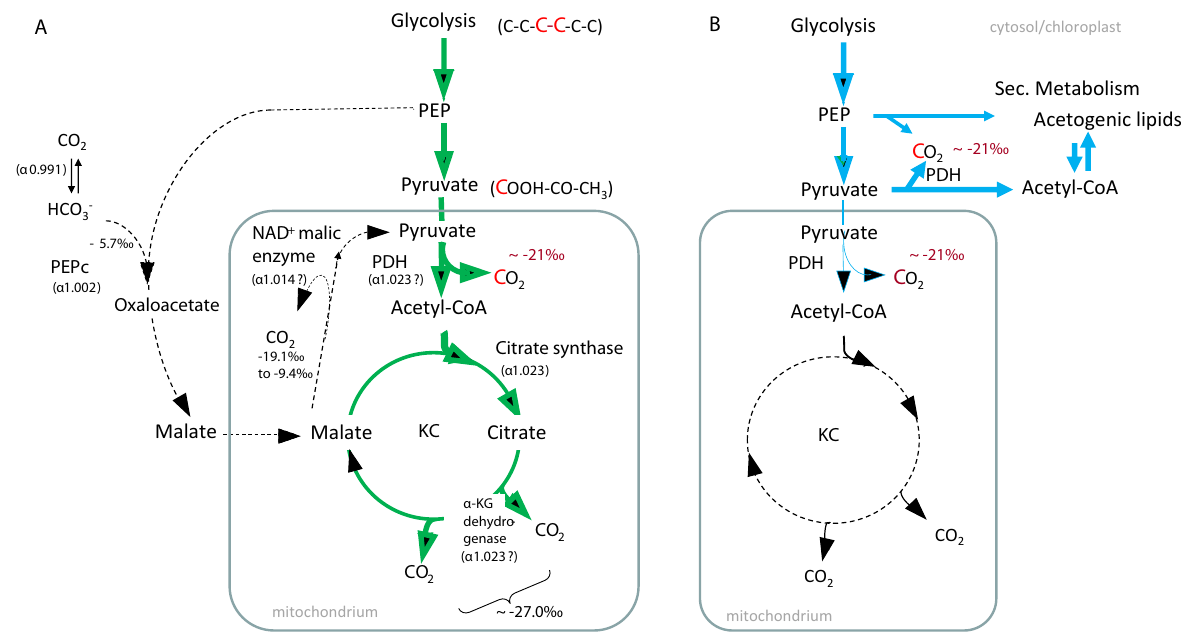
Fig. 5. Simplified metabolic scheme showing major fluxes of respiratory substrates (black arrows), isotopic compositions (‰) and fractiona- tion factors ( α ) of key enzymes and processes that influence δ 13 C res : C-1 of pyruvate which is decarboxylated during pyruvate dehydrogenase (PDH) reaction is 13 C-enriched ( − 21‰), while relatively depleted C-2 and C-3 ( − 27.0‰) which form acetyl-CoA enter the Krebs cycle (KC) (values based on Rossmann et al., 1991). Two distinct situations are indicated: (A) full decarboxylation of the carbon molecules in the Krebs cycle (KC) or (B) high investment into secondary metabolism and fatty acid synthesis. Isotope fractionation processes in the KC are exemplified by citrate synthase and α -ketoglutarate ( α KG) dehydrogenase ( α = 1 . 023) (see Tcherkez and Farquhar, 2005 and literature therein, Bulzenlechner et al., 1996; Melzer and Schmidt, 1987; Schmidt, 2003). Further, the potential involvement of an enriched malate pool ( − 5.1‰, Barbour et al., 2007) which is produced during phospoenolpyruvate carboxylase (PEPc) reaction with small kinetic enzyme fractionation against 13 C ( α = 1 . 002) and equilibrium fractionation against 12 C ( α = 0 . 991) during HCO − equilibration (O’Leary 1981, 3 Farquhar et al., 1989) is indicated in (A) (dashed line). The human malic enzyme fractionates in favour of 12 C ( α = 1 . 014, Rishavy et al., 2001, see Gessler et al., 2009b), the reaction following a Rayleigh distillation process after the light-dark transition (see also Barbour et al., 2007). Adapted from Barbour et al. (2007), Werner et al. (2009) and Gessler et al.